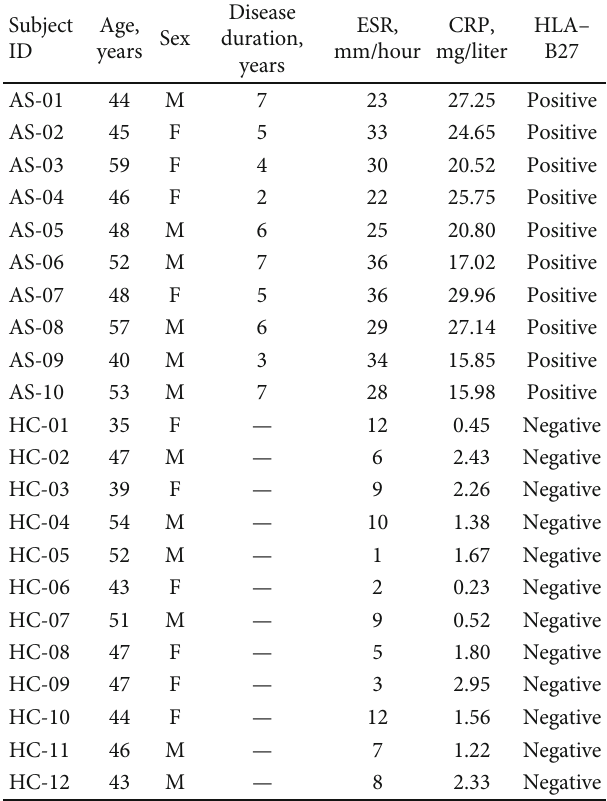
Table 1: The traits of the AS cases and HCs at the point of biopsy ∗